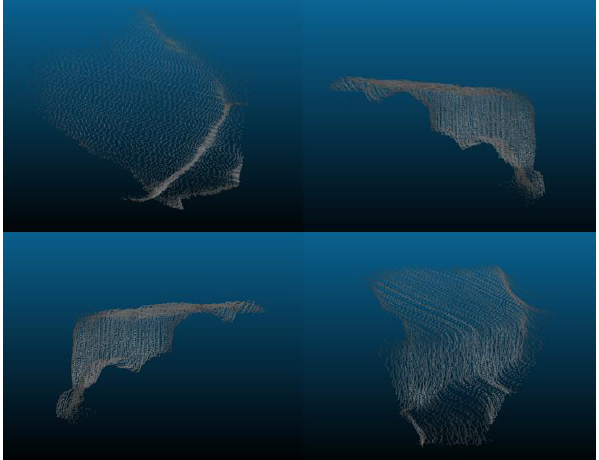
Figure 8. Top, left, front and iso view of a cropped scan of a single stone (30×40×20